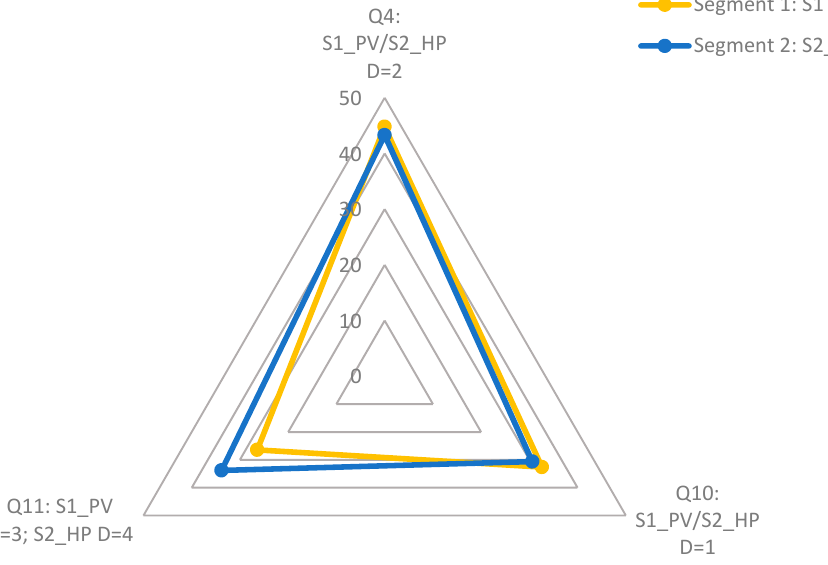
Figure 5. Prosumer behaviors related to saving thermal energy. Source: own